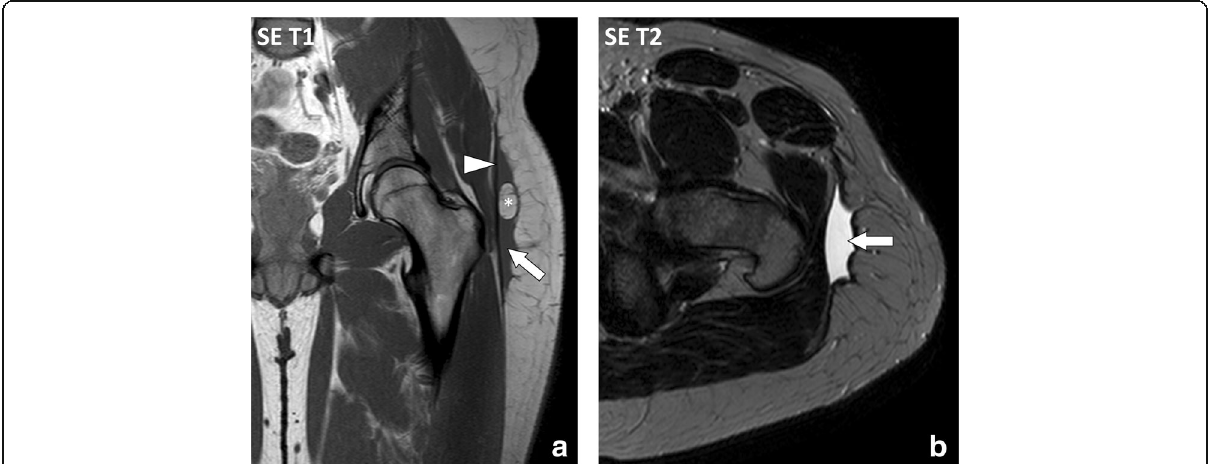
Fig. 2 a Coronal SE T1-weighted (T1w) and ( b ) axial SE T2-weighted (T2w) images of the left hip and proximal part of the left thigh of a 22-year-old male with Morel-Lavallée lesion after a street fight. MRI demonstrates an extensive lenticular fluid collection (arrows) deep to the hypodermis and superficial to the fascia lata (arrowhead). Note the large fat lobule bulging into the collection